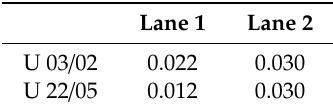
Figure 5. Calibration and validation outputs: ( a ) speed on lane 1 as simulated (dotted) and recorded (continuous), ( b ) speed on lane 2 as simulated (dotted) and recorded (continuous) and ( c ) traffic volumes .